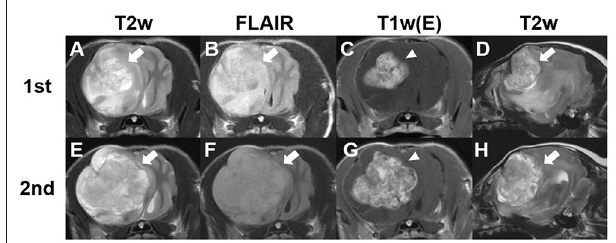
FIGURE 1 | Findings from the first and second magnetic resonance (MRI) imaging of a dog with meningioma. Transverse T2-weighted (A,E) , fluid-attenuated inversion recovery (B,F) , and post-contrast (C,G) images at the optic chiasm level and sagittal T2-weighted images (D,H) . The first MRI scan was performed before chemotherapy. A solitary amorphous mass (2.7 × 1.9 × 2.2cm) can be observed in the right frontal lobe. The tumor lesion (arrows) shows hyperintensity on T2-weighted (A,D) and fluid-attenuated inversion recovery (B) images. Post-contrast (C) image shows uniformly remarkable enhancement (arrowhead). Second MRI was obtained 355 days after initial chemotherapy (E–H) . A more severe midline shift compared with the findings of the first MRI scan can be observed and the size of the tumor increased to 3.5 × 2.8 × 2.9cm.